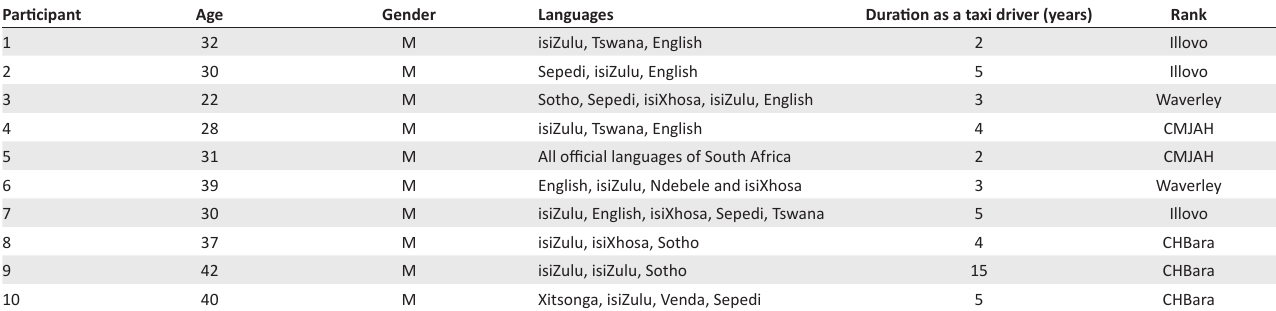
TABLE 1: The demographic profile of participants.